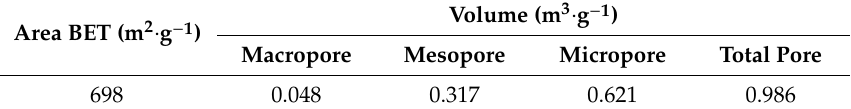
Table 3. Textural properties of the massaranduba activated carbon (AC).